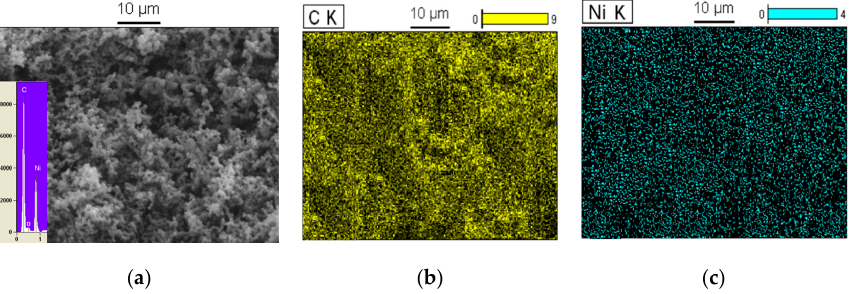
Figure 5. SEM/EDX image of Ni/C nanospheres ( a ); elemental mapping images of C at 1050 °C ( b ) and Ni at 1050 °C ( c ).